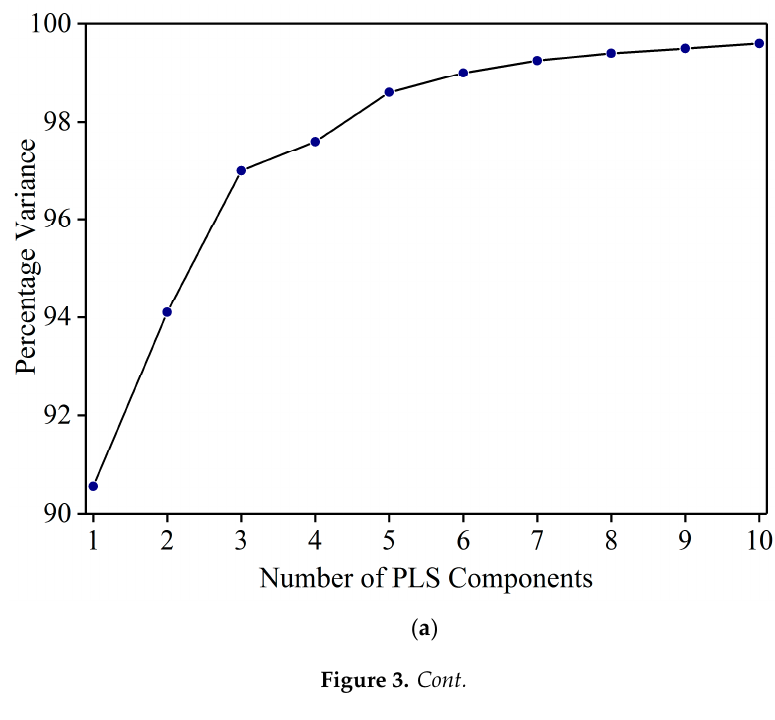
Figure 2. Spectra of yellow turmeric—Sudan Red sample ( a ) at 1% concentration ( b ) at 5%, 10%, 15%, 20%, and 25%